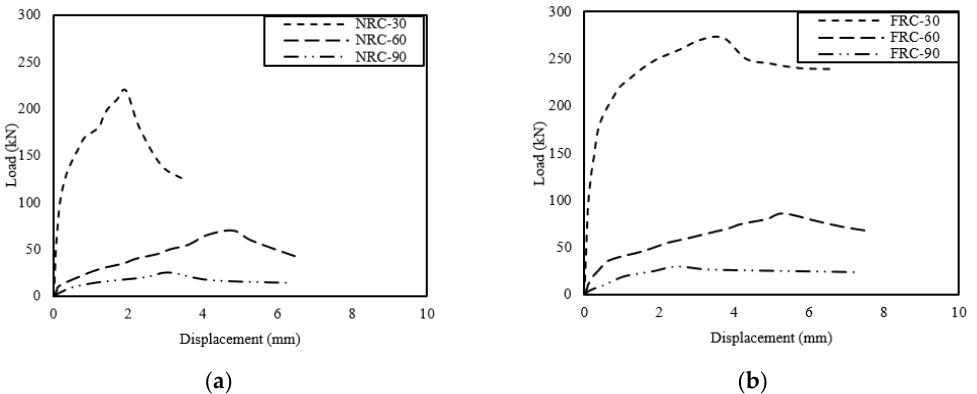
Figure 17. Load – relative deflection comparison between V-shaped columns of ( a ) NRC and ( b ) FRC specimens.